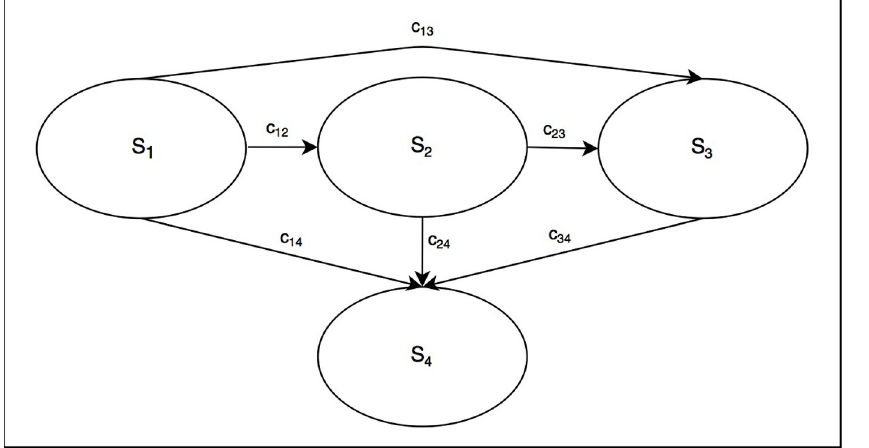
Fig 1. A 4-states continuous-time stochastic process used in numerical verification